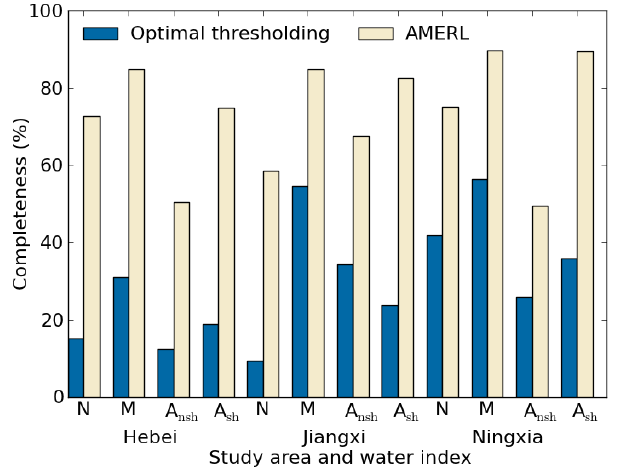
Figure 10. Improvement in completeness for the AMERL compared with the optimal thresholding method in twelve tests ( i.e ., four WIs and three study areas). The three study areas are Hebei, Jiangxi and Ningxia. The symbols N, M, A and A represent the nsh sh NDWI, MNDWI, AWEI and AWEI , nsh sh